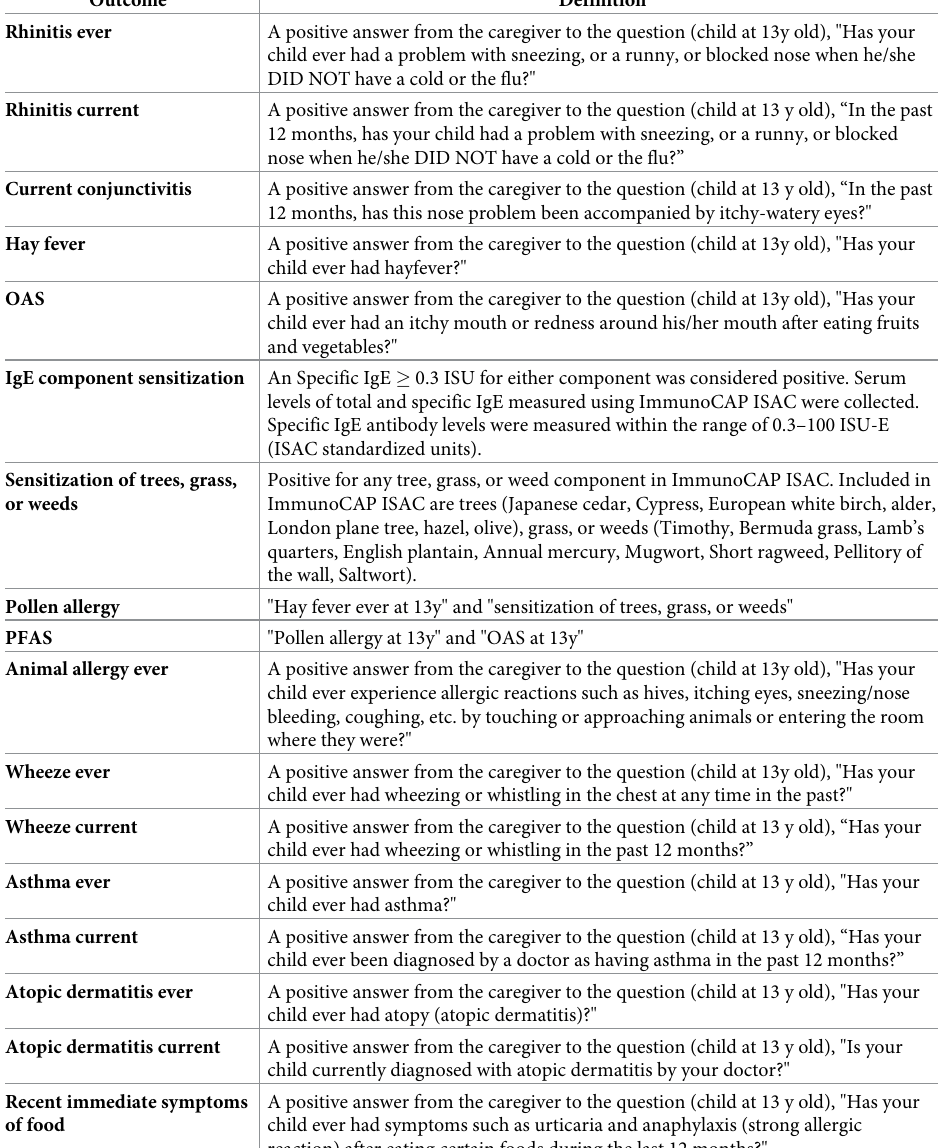
Table 1. Definitions of